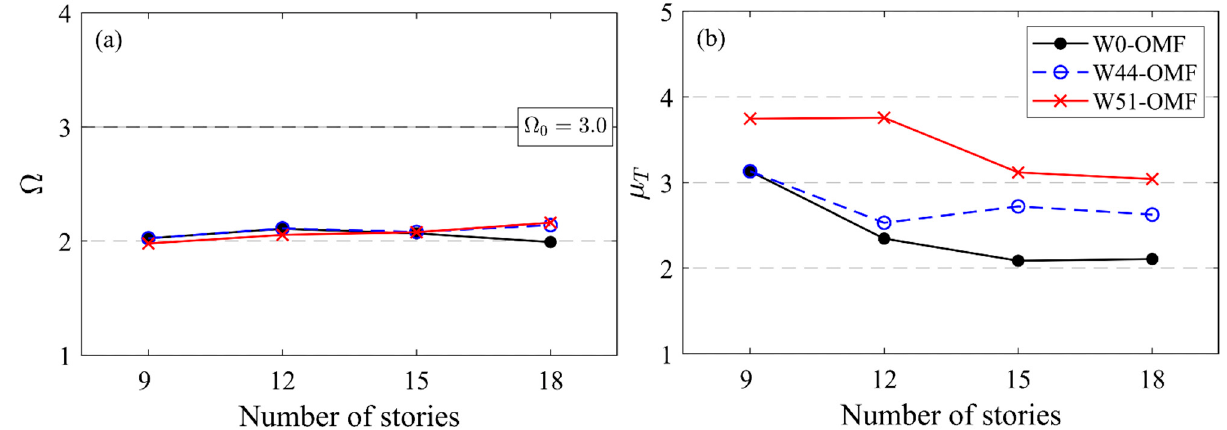
7 of 19 Figure 4. Result of pushover analysis for 9- and 15-story steel OMFs: ( a , c ) Pushover curves; ( b , d ) normalized floor displacement ( 𝛿 (cid:3036) /𝐻 ) of W0- and W51-OMFs at specific normalized roof displace- ments until collapse stage.